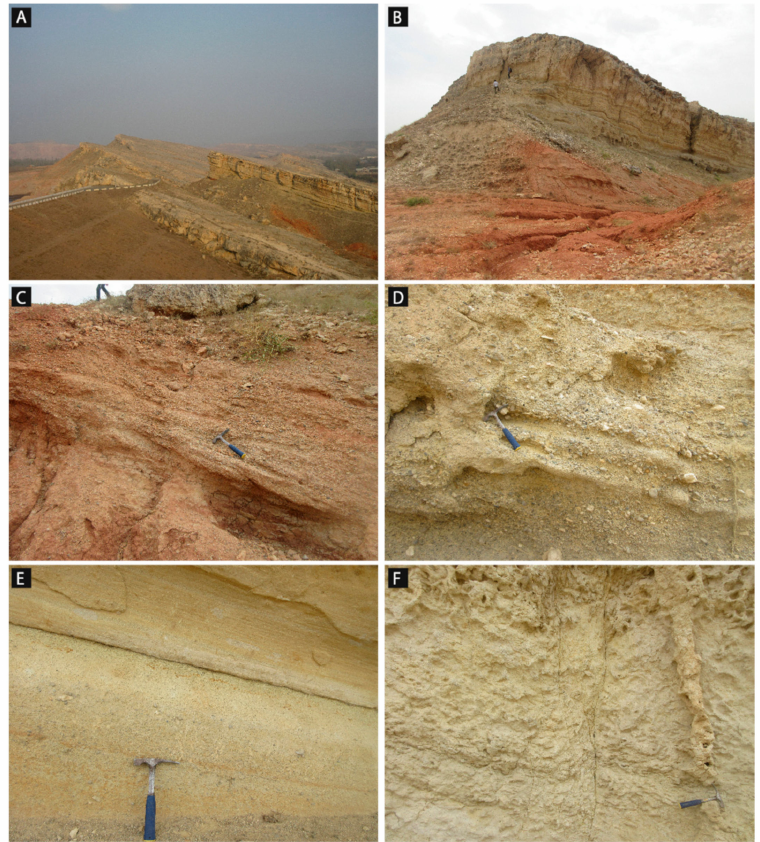
Figure 5. Field view of the sedimentary rocks at the Karabulak section of the northern Fergana Basin. ( A ) Eastward view from Karabulak, where two limestone beds and intercalating beds can be observed. The lower left part of the view shows the reservoir dam. ( B ) Clastics and overlying limestone. The clastics part was comprised of red beds, conglomerates, and fine-grained sandstone. The height of an average-sized man is shown for scale. ( C ) Red beds of conglomerate. Some low-angled cross-beds can be observed. ( D ) Crudely stratified conglomerate. Some clasts are sub-angular. ( E ) Parallel laminated fine-grained sandstone. A small number of burrows developed sporadically. ( F ) Densely developed burrows in the fine- to very fine-grained